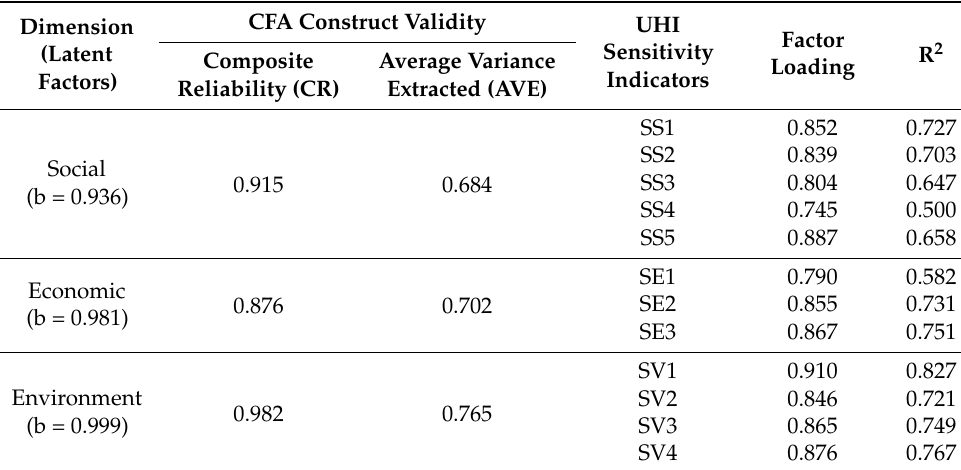
Table 7. First- and second-order CFA of UHI sensitivity indicators.